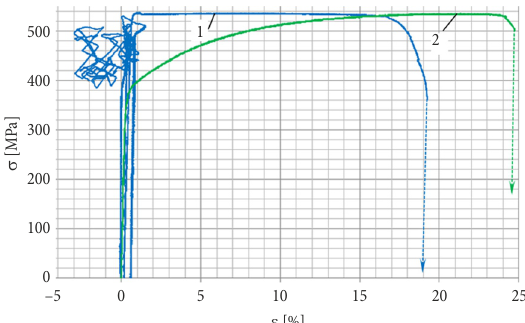
Fig. 5. Stress–strain curves for stainless steel 04Kh18N10: